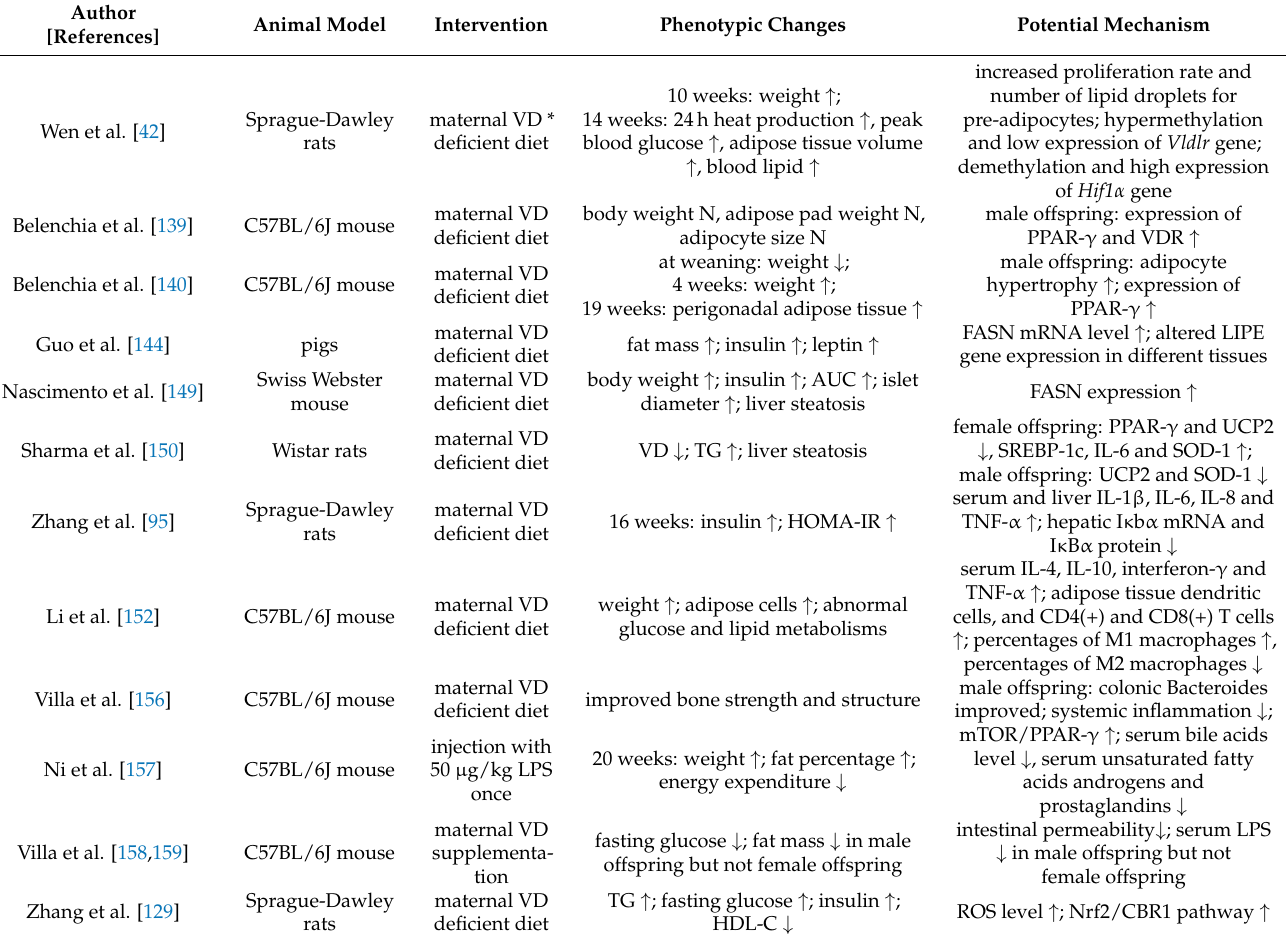
Table 2. Animal studies on potential mechanism of VD deficiency during pregnancy on offspring